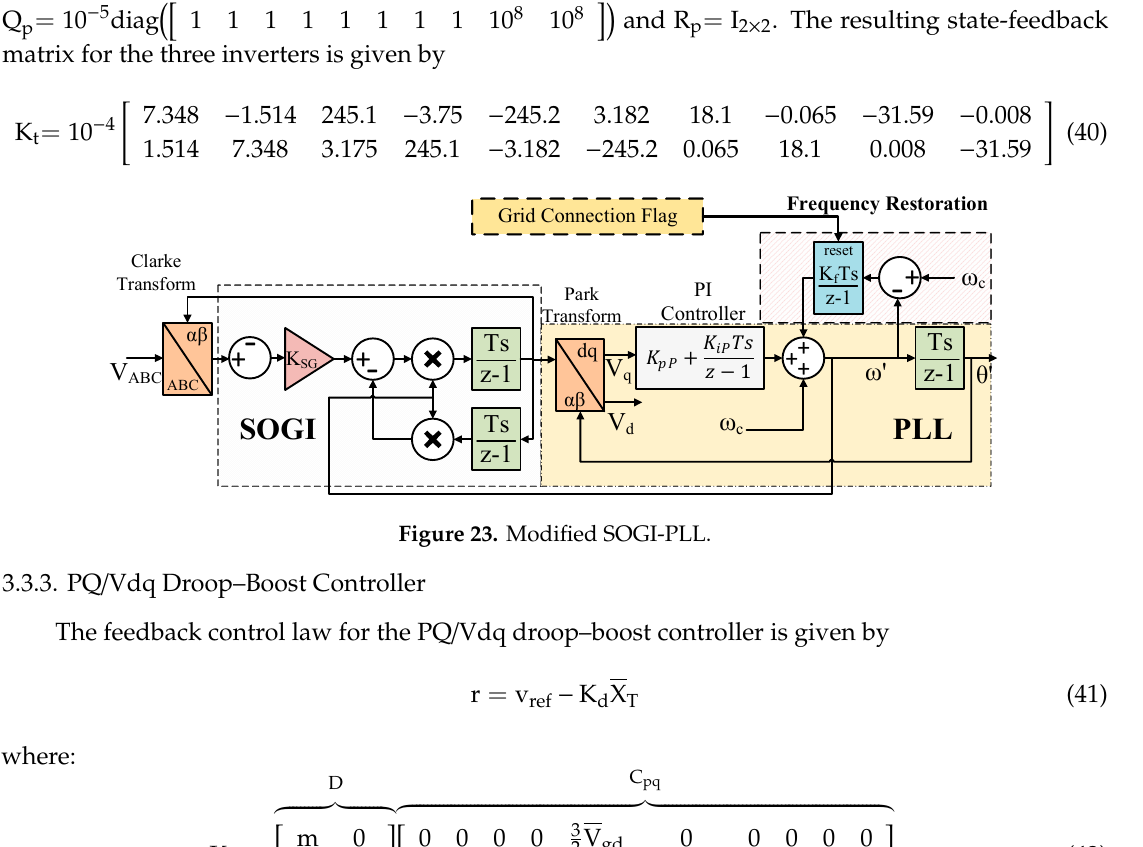
23 of 30 Figure 22. Control scheme for the PQ/Vdq controller. To synchronize each inverter with the AC bus, a second order generalized integrator (SOGI- PLL) is implemented as shown in Figure 23 [33]. The output of the SOGI-PLL is used to perform the dq transformation of the input and output signals of the LQI controller. When the grid connection is